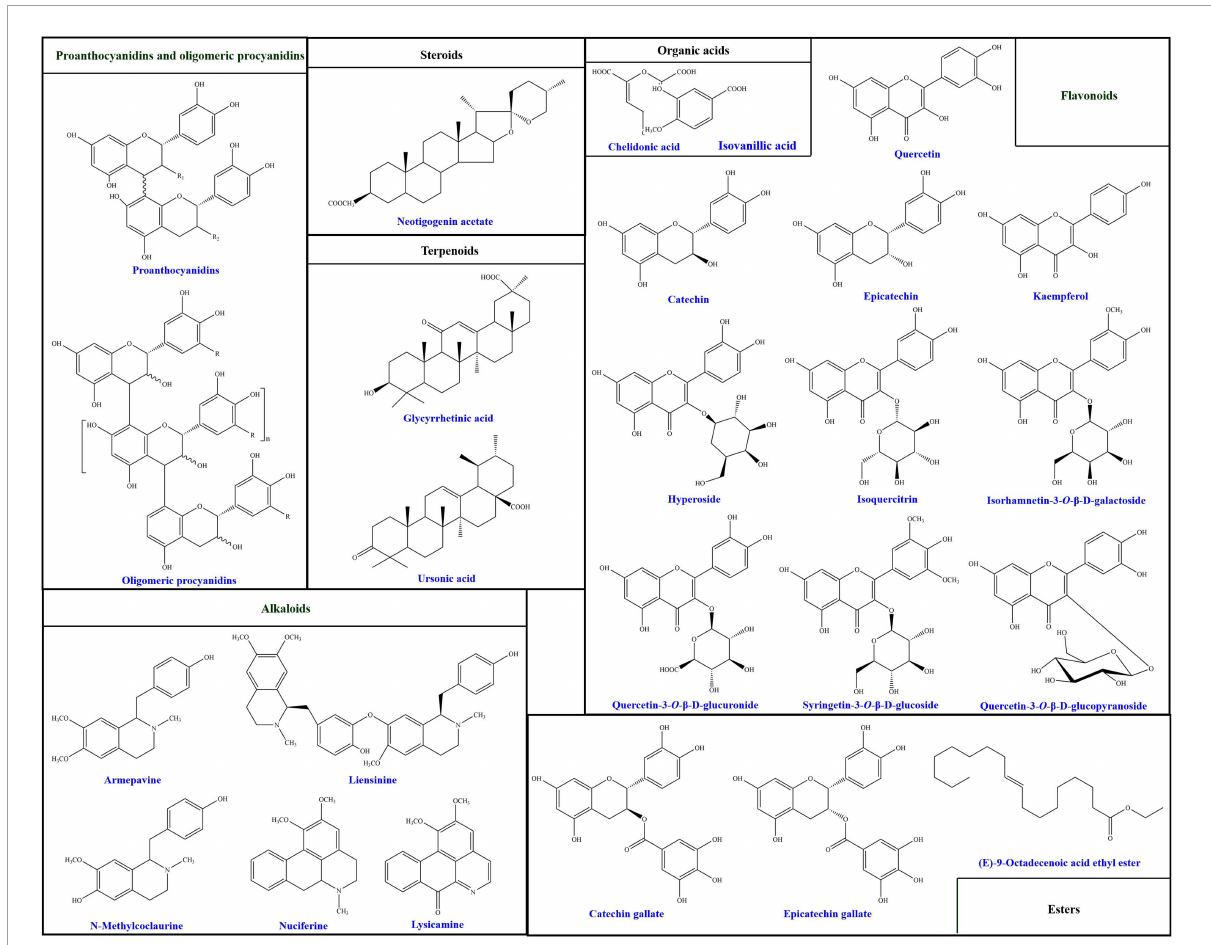
FIGURE2 Chemical structures of some compounds identified in lotus seedpods. These chemical structures are redrawn on the basis of previous studies (8, 34, 35, 38, 39, 41, 44,